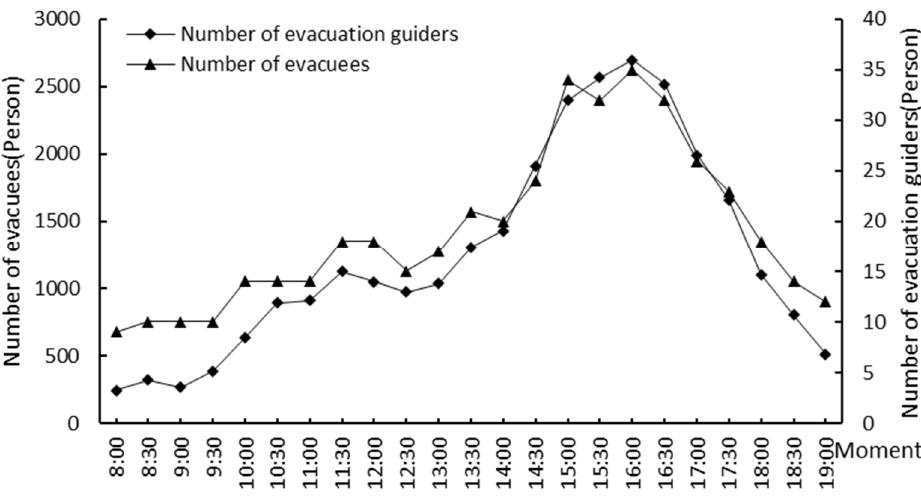
Figure 9. Changes in the number of evacuees and evacuation guiders at different moments on 5 May 2021.